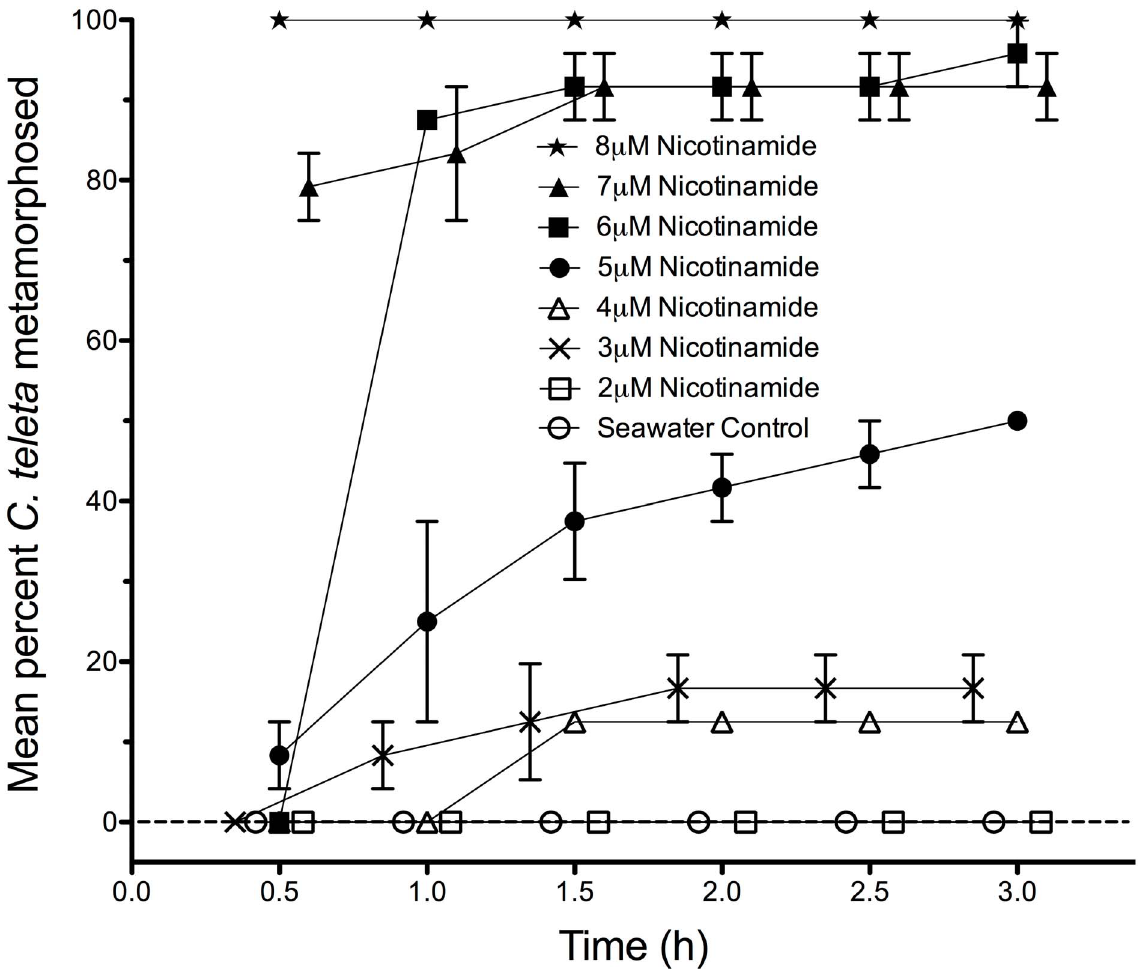
Figure 1. Promotion of metamorphosis by nicotinamide (vitamin B 3 ) in larvae of Capitellateleta . Each treatment consisted of 3 replicates with 8 larvae per replicate. Larvae were placed in 30 ppt artificial seawater (Instant Ocean) containing the indicated final concentration of nicotinamide. Artificial seawater acted as a negative control. Error bars represent + / 2 1 s.e.m.